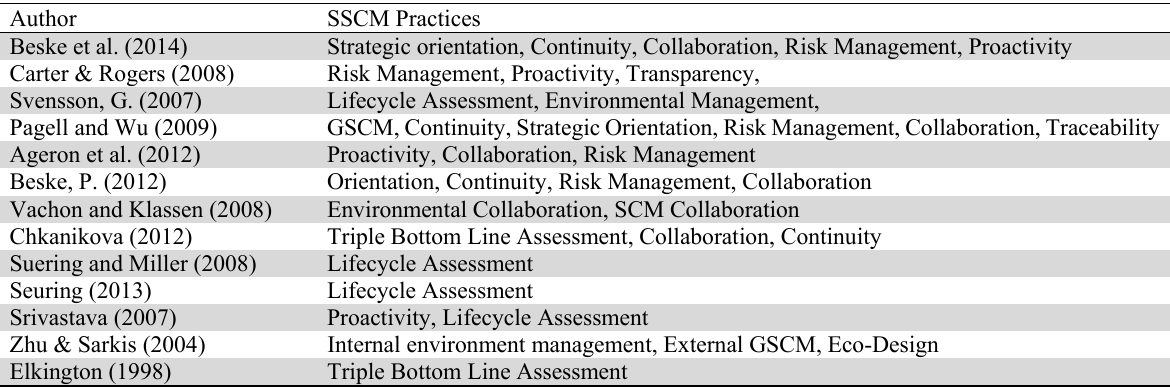
Sustainable SSCM